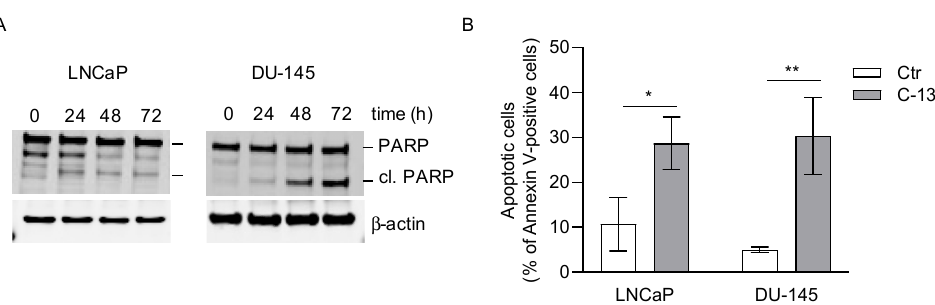
Figure 7. C-1311 induces apoptosis irrespective of AR status. ( A ) Western blotting analysis of apoptosis-related PARP cleavage. PCa cells were treated with DMSO or 1 µ M C-1311 for the time indicated. β -actin was used as the loading control, n = 3. ( B ) The percentage of apoptotic cells determined by flow cytometry analysis of Annexin V / propidium iodide staining (PI). PCa cells were treated with DMSO or 1 µ M C-1311 for 72 h. The bar graph shows the percentage of total Annexin V-positive cells, including Annexin V +/ PI − (early apoptosis) and Annexin V +/ PI + (late apoptotic cells). Results are the mean ± SD, n = 3. Significance: Student’s t -test; * p < 0.05; ** p < 0.01.3.